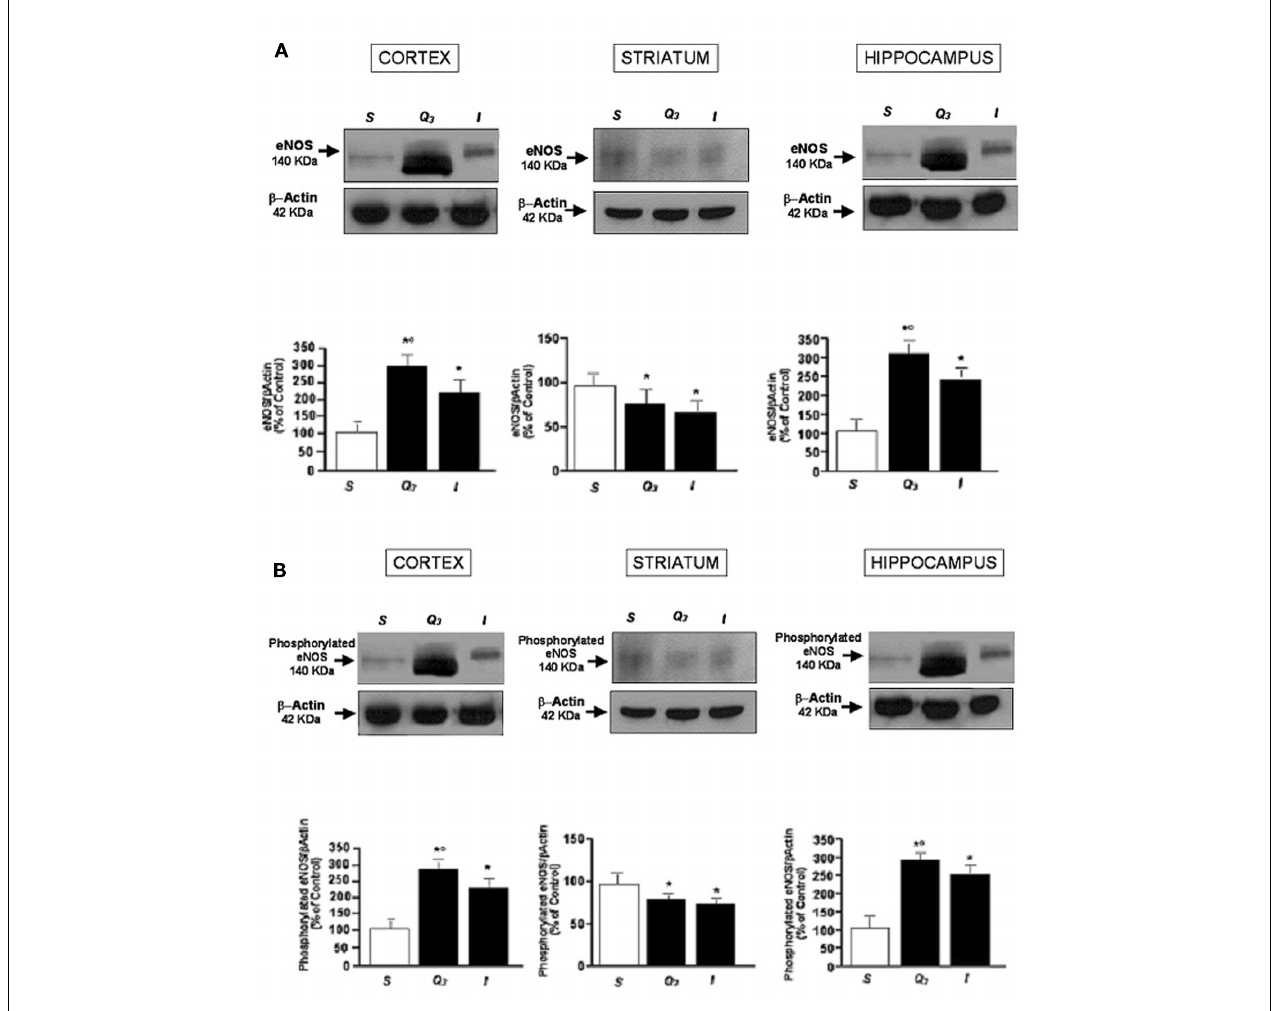
FIGURE 4 |Western blotting of eNOS expression (A) and phosphorylated eNOS expression (B) in three cerebral zones (cortex, striatum, hippocampus) at the end of reperfusion in sham- operated group, in Q 3,